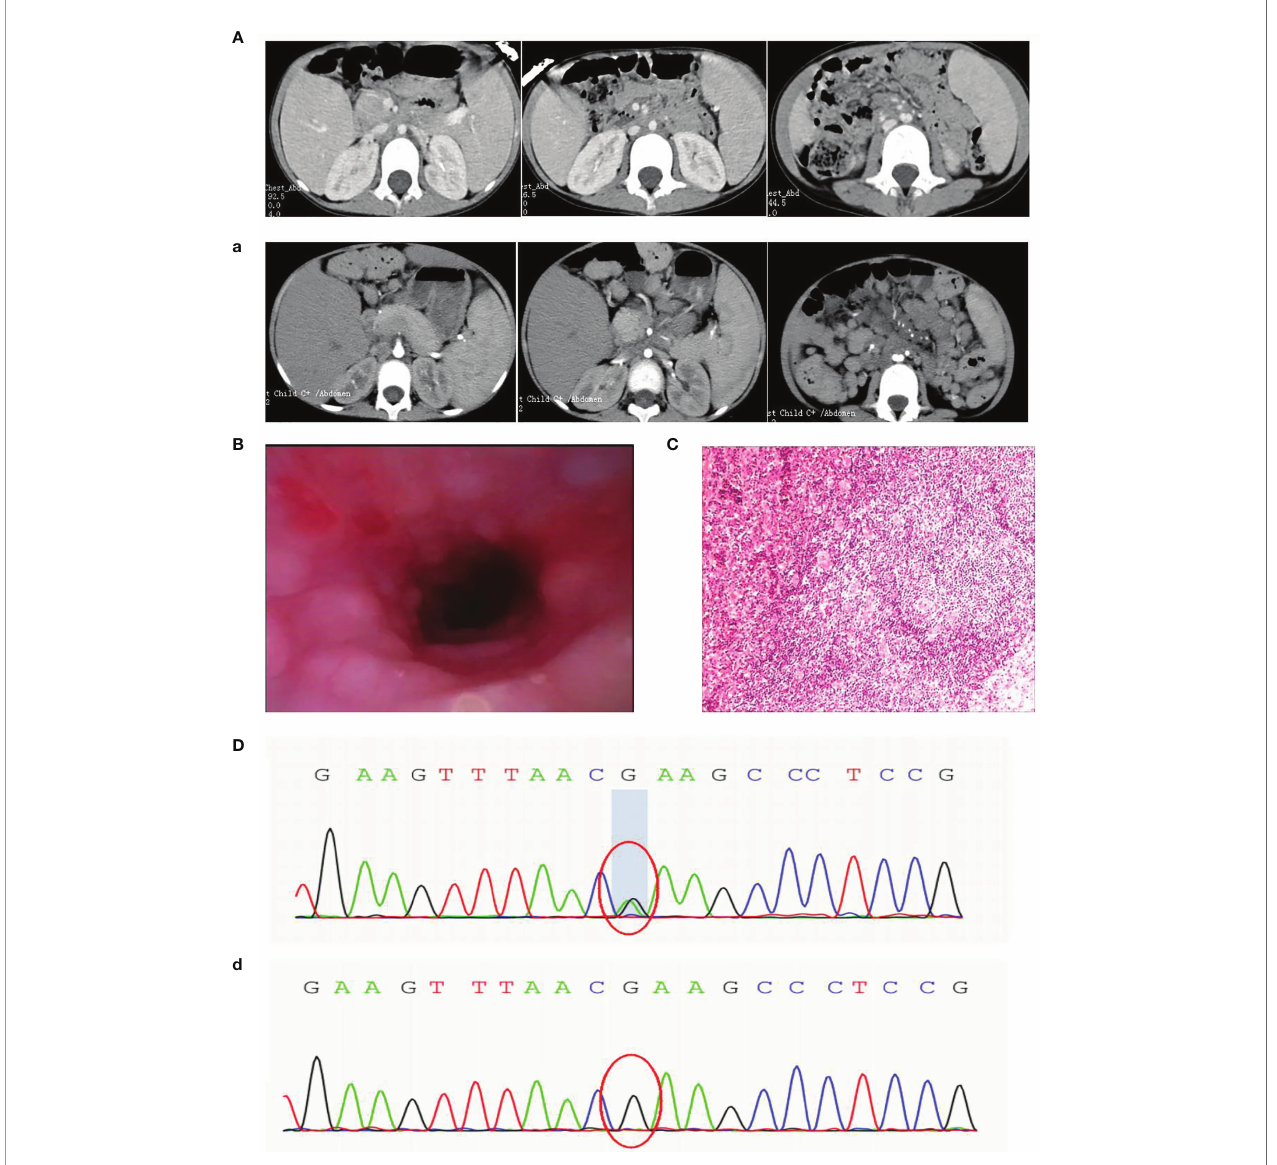
( Figure 1D ), and the family genealogy veri fi ed that both parents were normal. She was treated with gammaglobulin, ganciclovir and antibacterial drugs; fever and pulmonary symptoms resolved. However, the patient did not return to the hospital for follow-up treatment after